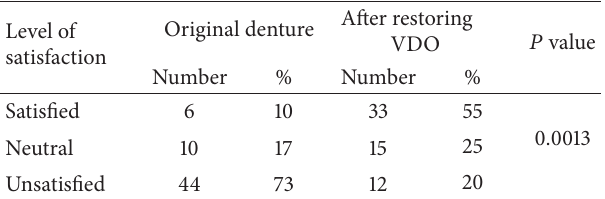
Table 3: Patients’ ( 𝑛 = 60 ) satisfaction with their original complete dentures, and after relining and restoration of the